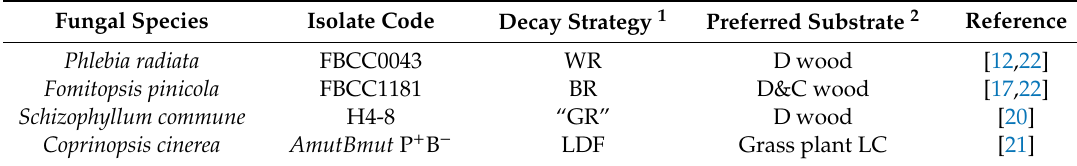
Table 1. Fungal isolates used in this